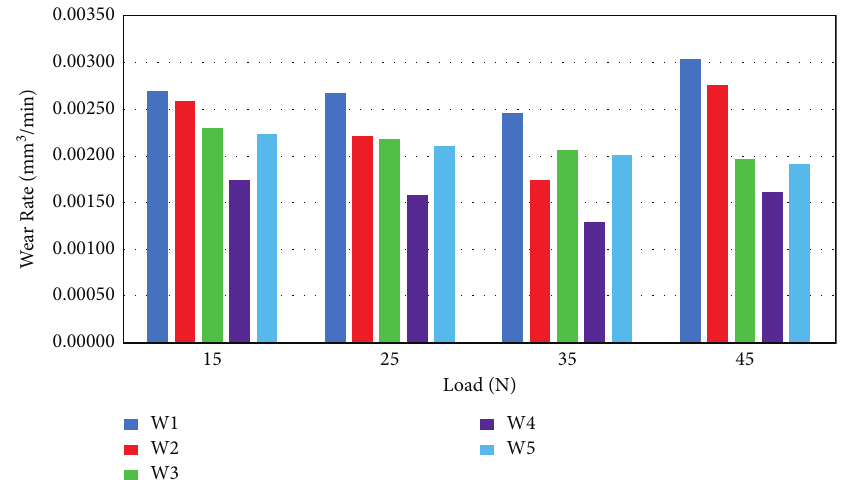
Figure 7: Variation on the wear rate of composites for 750m sliding